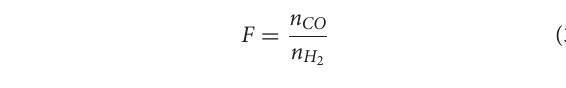
(F, Eq. 32) as a function of